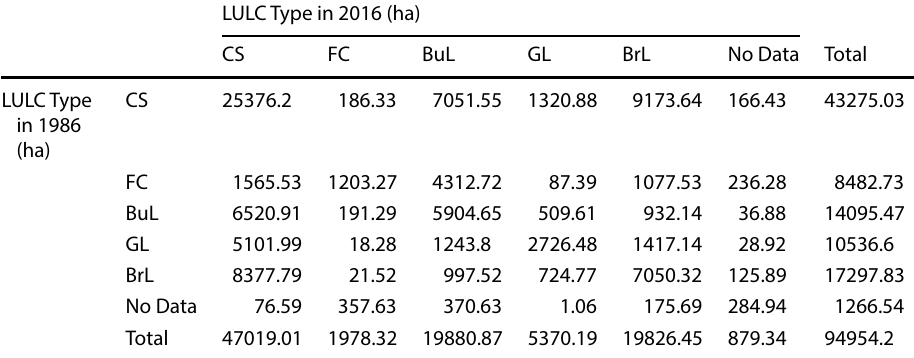
Table 10 LULC conversion matrix of the Gubalafto district between 1986 and